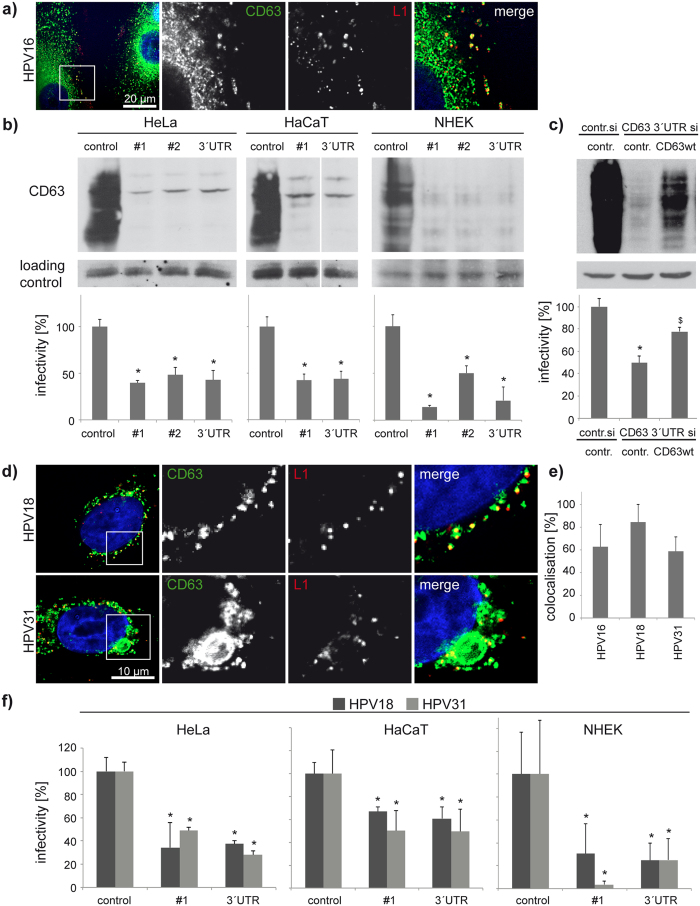
CD63 is required for HPV16, -18, and -31 infections.(a) HPV16 is internalised into CD63-positive endosomal compartments in primary keratinocytes (NHEK). NHEK cells were infected with HPV16 for 7 hours and stained with CD63 monoclonal antibody (mAb) and L1-polyclonal antibody (pAb) K75. Shown are representative pictures of endogenous CD63 (green) and HPV16 L1 (red). (b) CD63 knockdown correlates with reduced infectivity. Upper panels show efficiency of CD63 knockdown in HeLa, HaCaT and NHEK cells by Western blotting. Bottom panels show HPV16 pseudovirus (PsV) infection assay of HeLa, HaCaT and NHEK cells after CD63 siRNA treatment. Infectivity was measured by luciferase activity and normalized by LDH measurements. Infection rate of control siRNA was set to 100%. (c) HPV16 infectivity can be restored after reexpression in CD63 depleted cells. HeLa cells were treated with CD63 siRNAs, transfected with CD63-expression or control plasmid and infected with HPV16 PsV. Infectivity of HPV16 PsV was analysed as above. Upper panels show the efficiency of knockdown and reexpression. (d) HPV18 and -31 are internalised into CD63-positive endosomal compartments. NHEK cells were infected with HPV18 or HPV31 PsV and analysed as in (a). (e) Quantification of L1 colocalisation with CD63 was performed by analysis of at least 12 images (3–5 cells per image) using Colocalisation Software 4.7 (Zeiss). Shown is the proportion of CD63-colocalising L1 pixels relative to the total amount of L1 pixels. (f) HeLa, HaCaT, and NHEK cells were treated as in (b) and HPV18 and HPV31 PsV infectivity after CD63 knockdown was analysed as above. *P < 0.05 significant decrease compared to control, $P < 0.05 significant increase compared to cells transfected with CD63 3′UTR siRNA and control plasmid.